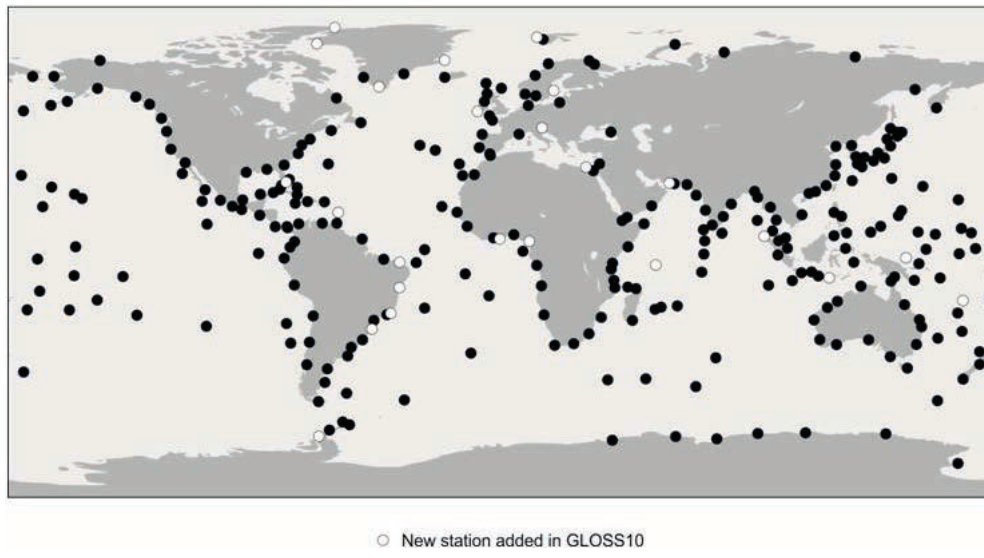
Fig. 2 The GLOSS Core Network